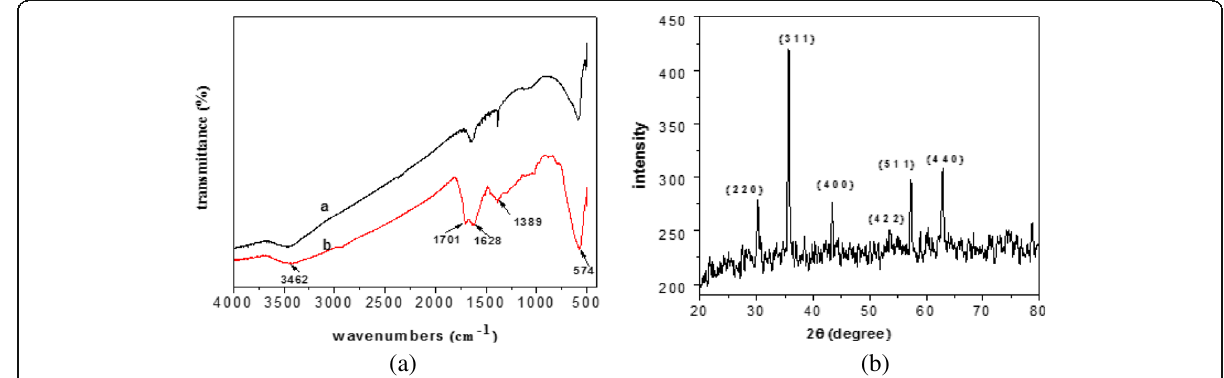
Fig. 2 FT-IR and XRD spectrum of the resulting products. a FT-IR spectrum (a: Fe 3 O 4 , b: MCMs). b XRD spectrum of Fe 3 O